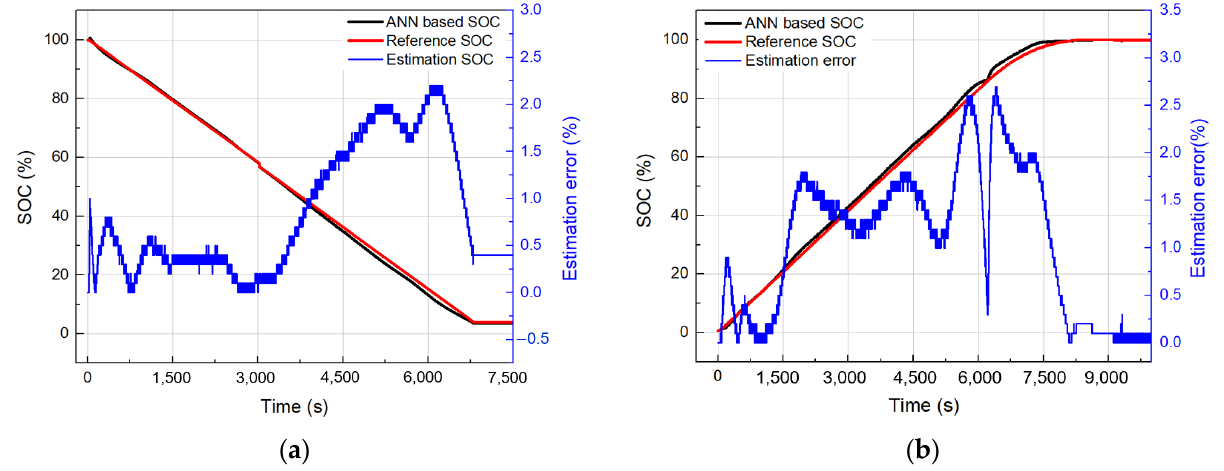
Figure 17. Experiment results of the SOC estimation using the ANN: ( a ) discharge; and ( b ) charge.